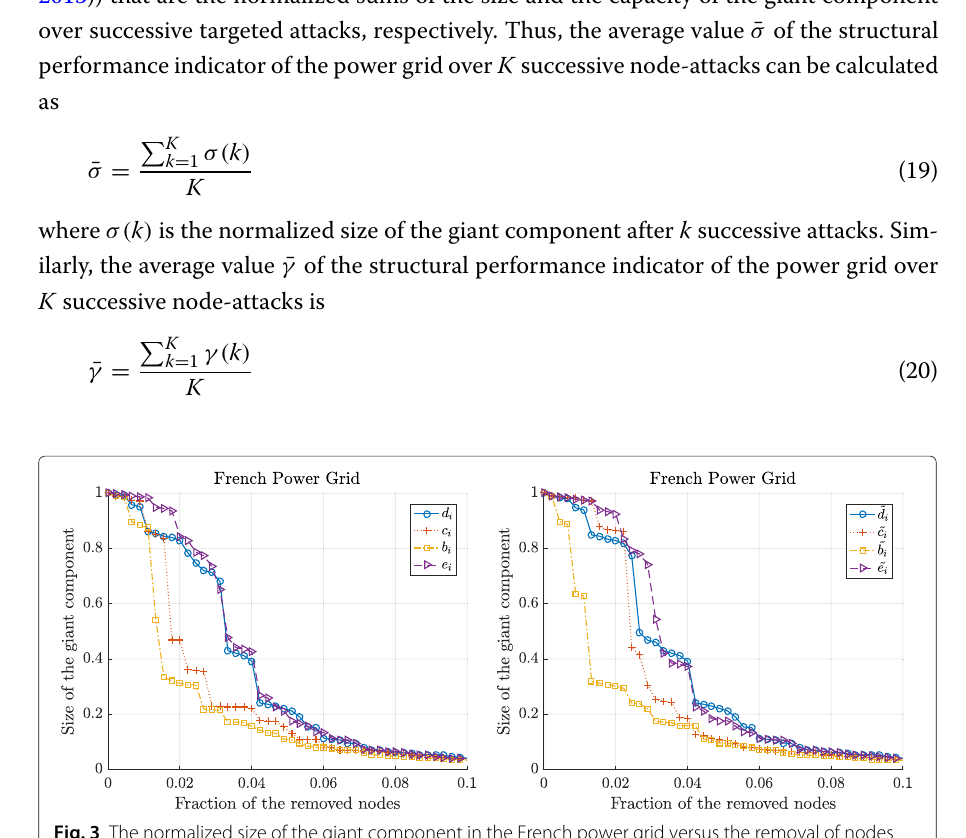
Fig. 3 The normalized size of the giant component in the French power grid versus the removal of nodes according to the standard centrality metrics (left) and the extended centrality metrics (right). The node with optimal graph metric, computed in resulting giant component, is